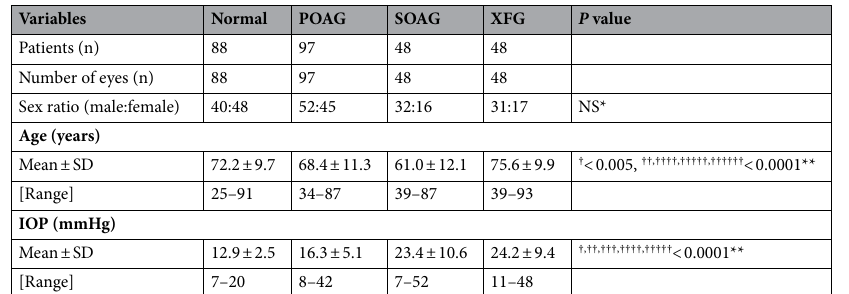
Table 1. Demographic characteristics of the study population. POAG primary open angle glaucoma, SOAG secondary open angle glaucoma, XFG exfoliation glaucoma, IOP intraocular pressure. *Fisher’s exact test. **Steel–Dwass test. † Statistically significant difference between normal and POAG (Steel–Dwass test). †† Statistically significant difference between normal and SOAG (Steel–Dwass test). ††† Statistically significant difference between normal and XFG (Steel–Dwass test). †††† Statistically significant difference between POAG and SOAG (Steel–Dwass test). ††††† Statistically significant difference between POAG and XFG (Steel–Dwass test). †††††† Statistically significant difference between SOAG and XFG (Steel–Dwass